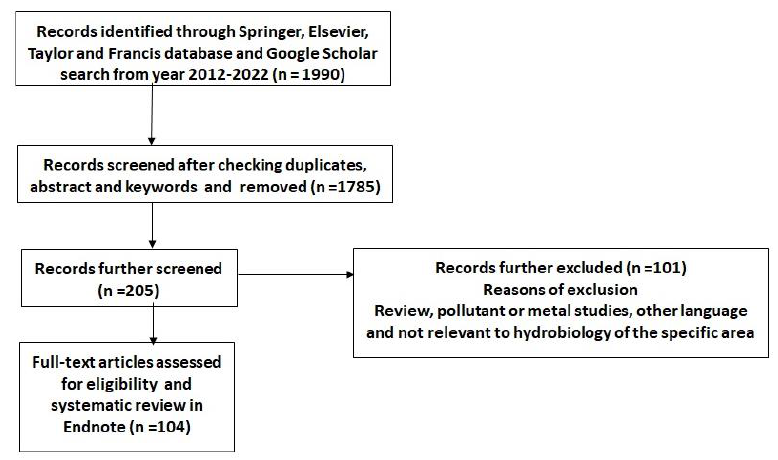
Figure 3. Review framework adopted for this study.